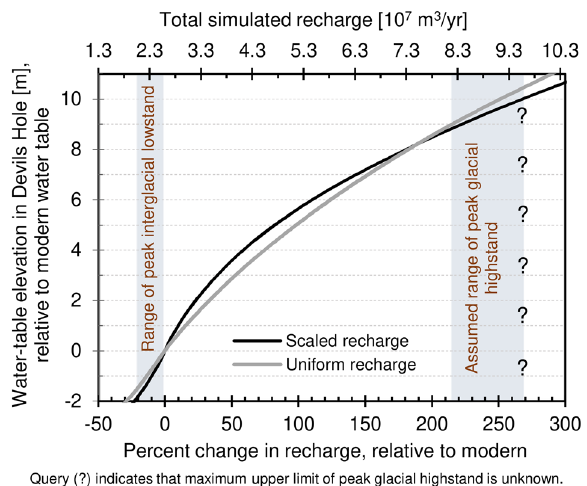
Fig. 3 Total simulated recharge for different paleo-water-table elevations. Total simulated recharge to Ash Meadows groundwater basin and percent change from modern (0%) recharge for different paleo-water- table elevations at Devils Hole relative to the modern water table at 0